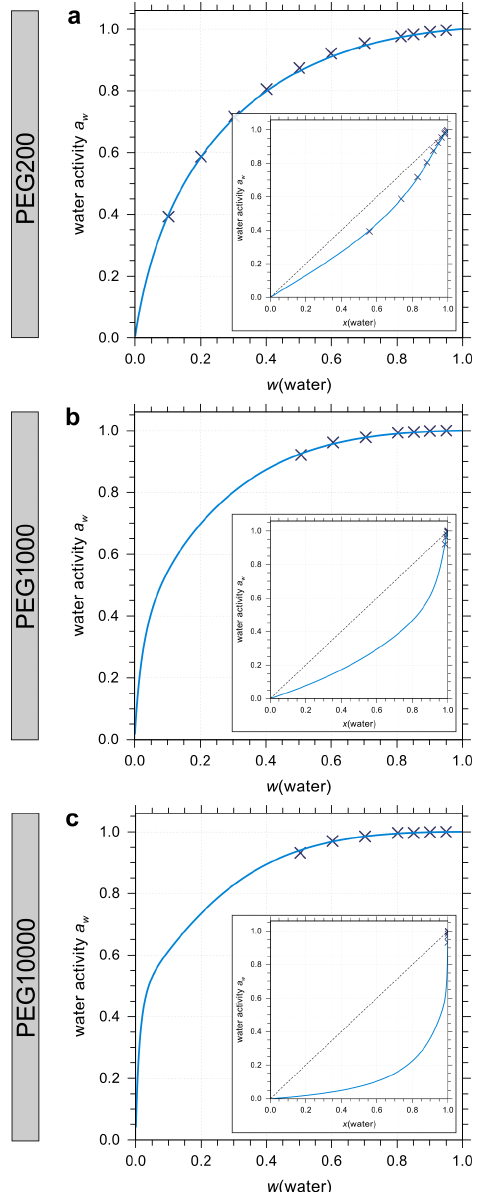
Figure A2. Comparison of measured and predicted water activity vs. mixture composition at 298.15K. Experimental data (crosses) are from Ninni et al. (1999). The blue curves show the specific AIOMFAC predictions for the mole-fraction-based water activity of aqueous PEG200 (a) , PEG1000 (b) , and PEG10000 (c) mixtures vs. mass fraction of water, w (water). The insets show water activity vs. mole fraction of water, x (water); the dotted diagonal line shows the water activity of a hypothetical ideal solution. The deviations be- tween ideal and non-ideal a w curves indicate the pronounced devi- ation from ideal solution behavior with increasing molar mass (i.e., increasing molecular size) of the PEG component (from a to c